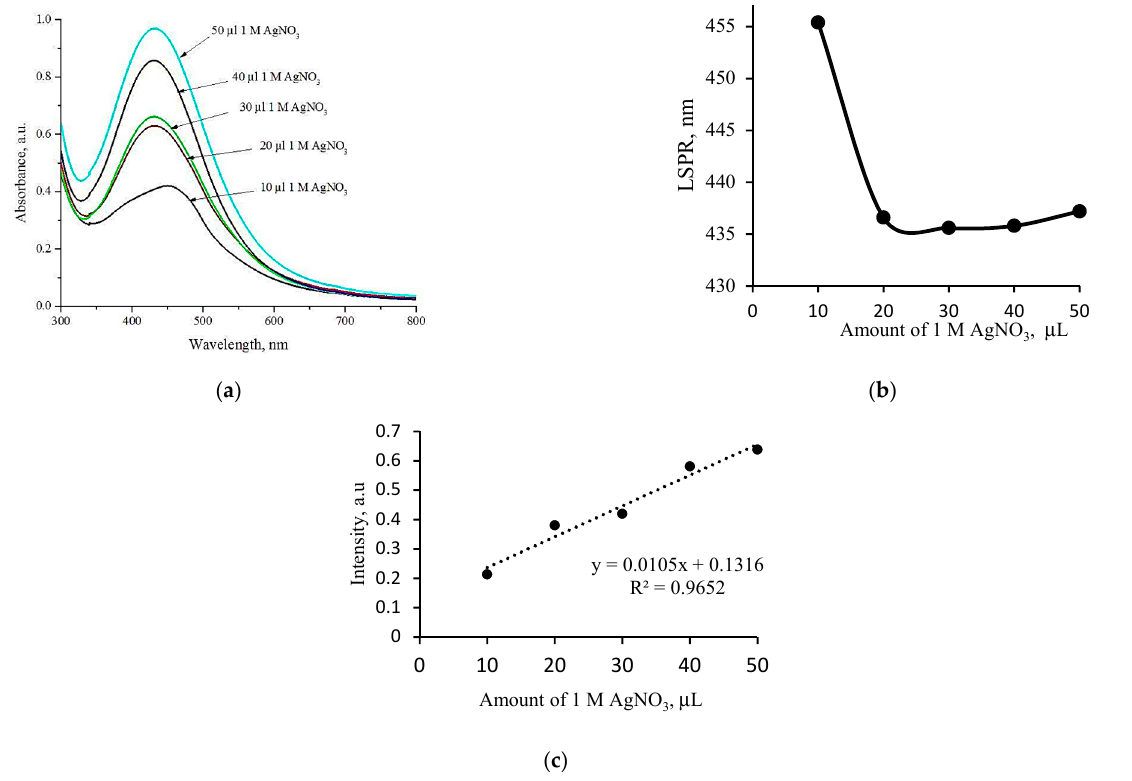
Figure 5. Silver-nitrate-concentration-dependent optical properties of silver-enriched beetroot–gelatin nanocomposite films: UV-VIS absorbance spectra ( a ), concentration-dependent LSPR peak position ( b ) and concentration-dependent intensity variations of LSPR peak ( c ).